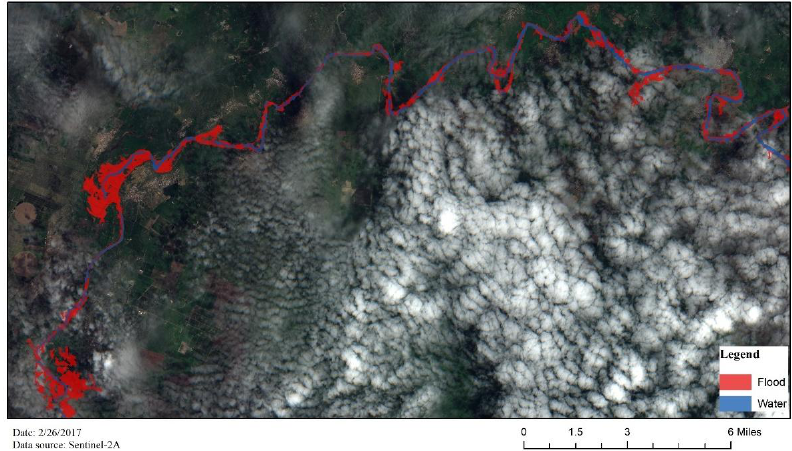
Figure 8 . Flood inundated areas in study area on February 27,2017 from Copernicus